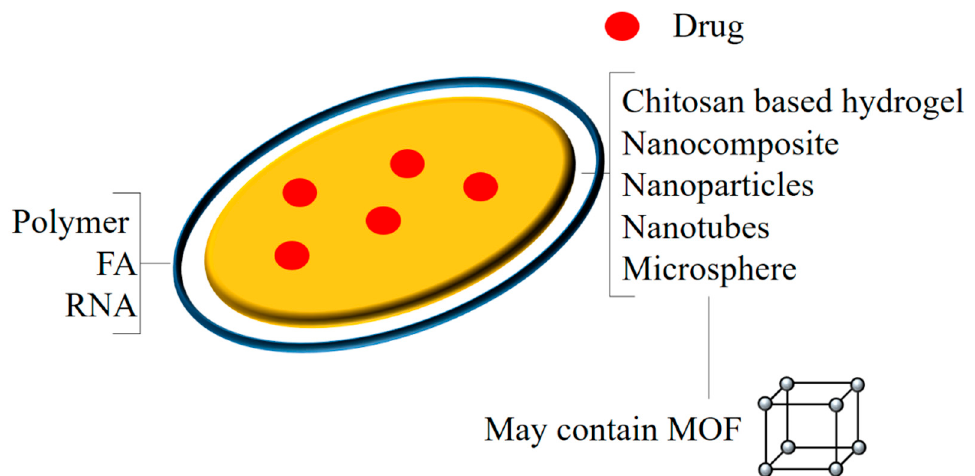
Figure 3 .A generalized structure of chitosan ‐ based nanohybrids. Figure 3. A generalized structure of chitosan-based